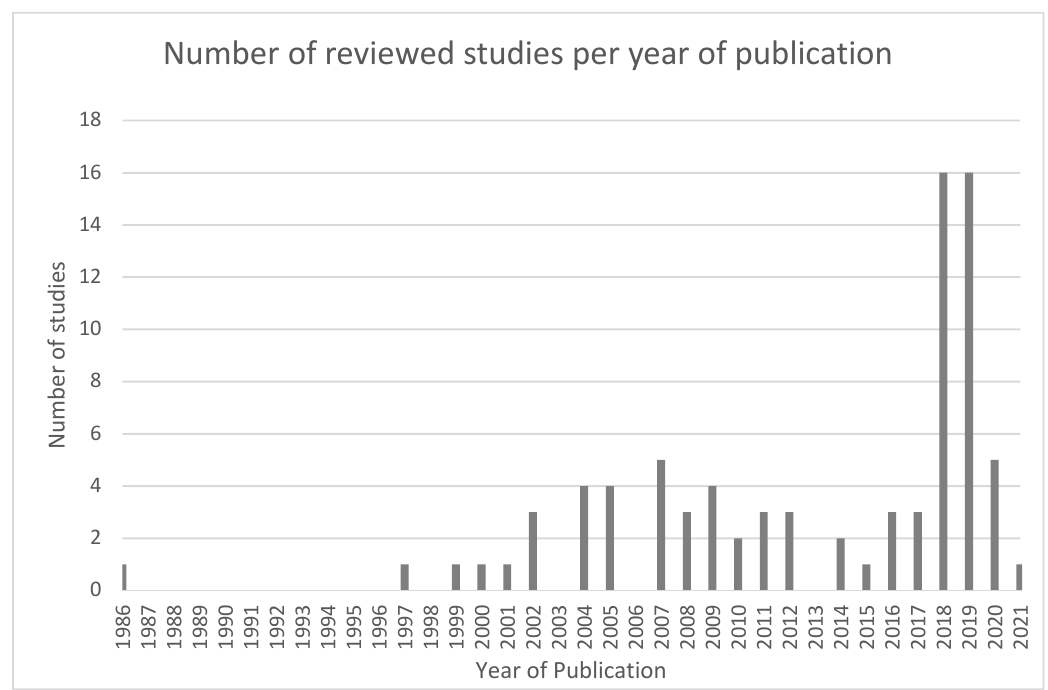
Figure 2. Distribution of reviewed studies included in analysis, by year of publication (total n = 83).